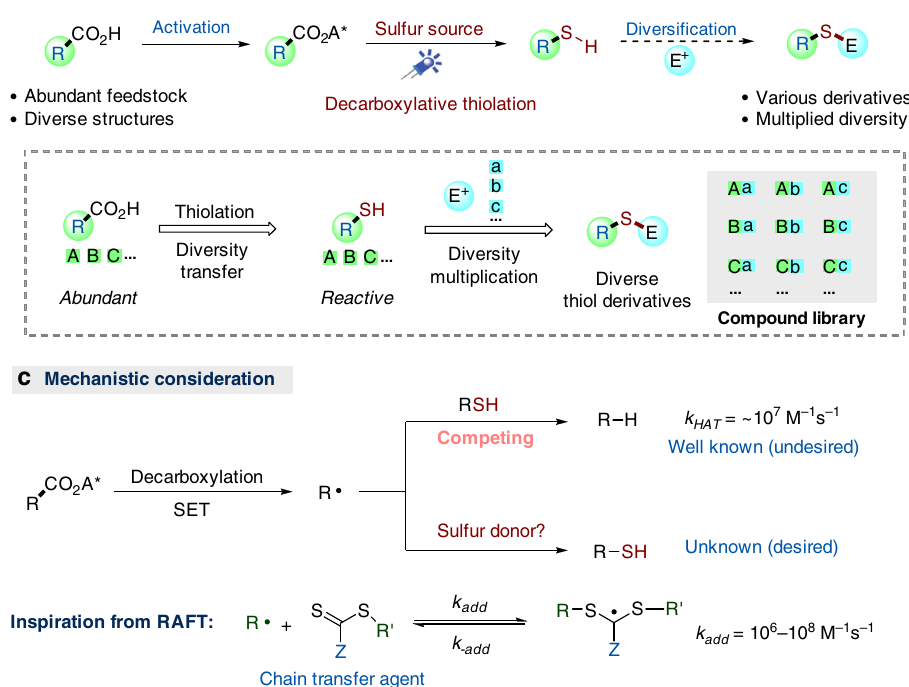
Fig. 1 Reaction design. a Thiols in functionality transformation and protein modi fi cation. b Diversity-oriented decarboxylative thiolation to free thiols. c Mechanistic consideration and the inspiration from reversible addition-fragmentation chain-transfer (RAFT)